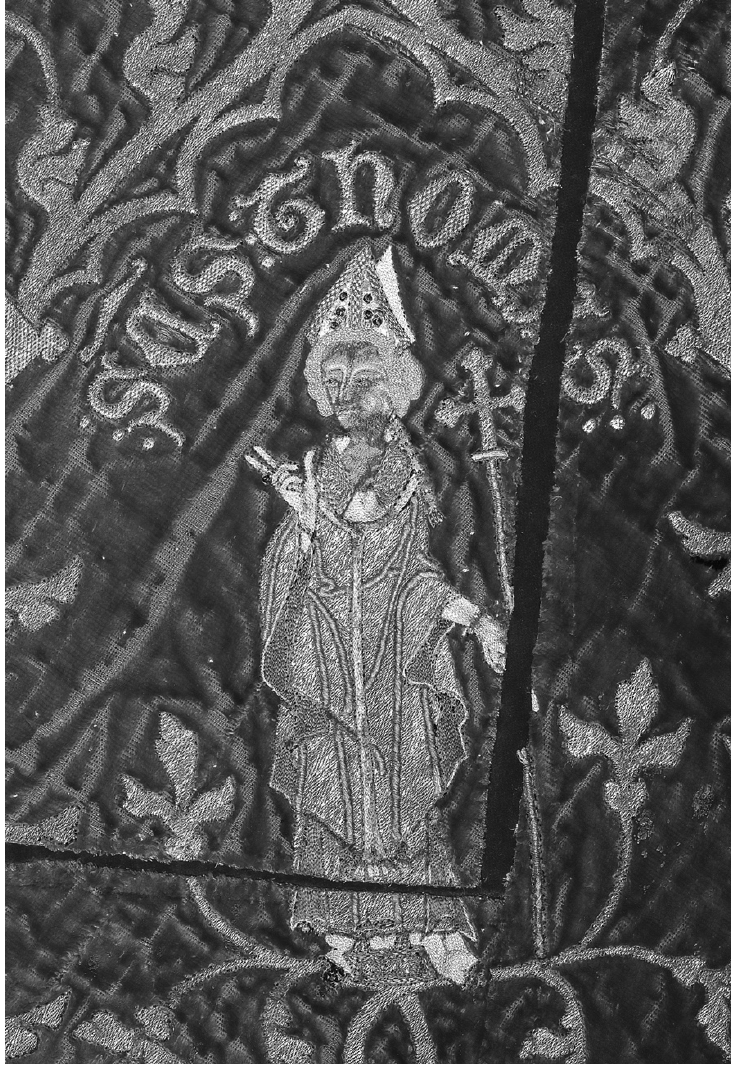
Figure 23. Vic Cope, detail of Thomas Becket in full-length, ca. 1350–1375, from Vic Cathedral. Vic, Museu d’Art Medieval, Spain © MEV, Museu d’Art